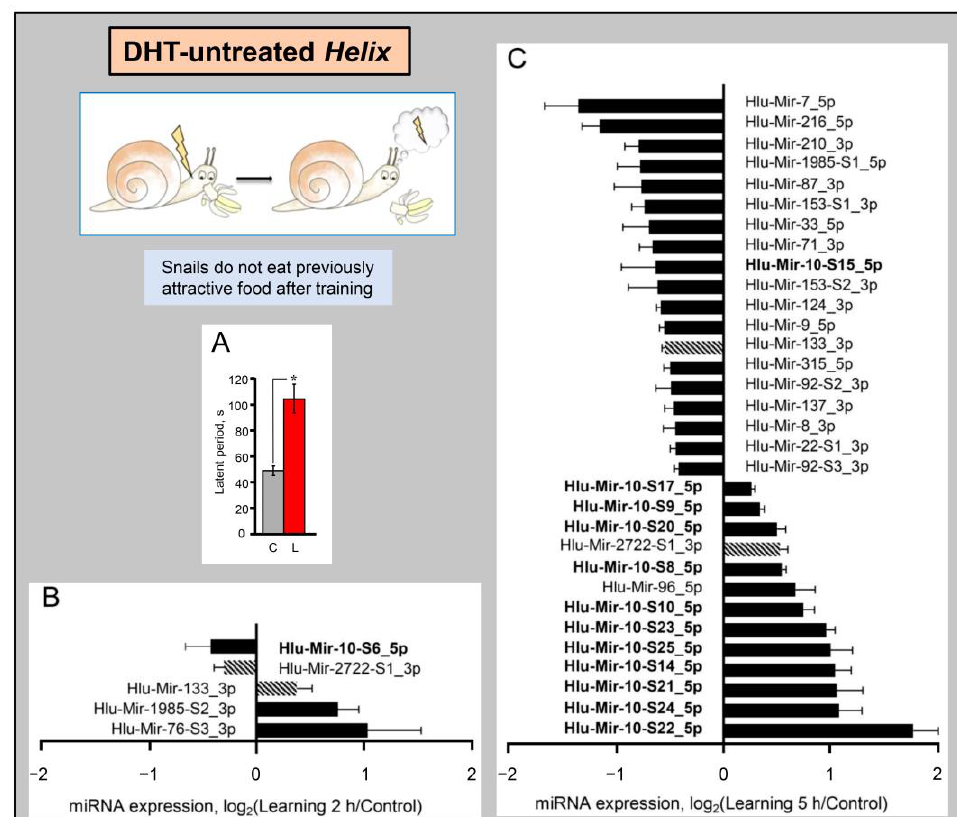
Figure 4. Learning regulates miRNAs expression in Helix CNS. ( A ) The formation of the food-avoidance conditioning in Helix. Testing after 3 days shows significant learning effects. The ordinate is the latent period of the consummatory responses of animals. Designations: C-animals before training ( n = 12), L-trained animals ( n = 12). * p < 0.05. ( B , C )-Relative expression levels of miRNAs 2 h ( B ) and 5 h ( C ) after learning were assessed using next-generation sequencing normalizing first to the total number of miRNA reads in each sample and then to the mean expression value in control groups of naive animals. The hatched columns indicate miRNAs which show differential expression both 2 and 5 h after learning. Statistical significance was assessed using the U-test ( p < 0.05). The error bars represent the standard error of the mean. The number of samples in experimental groups is as follows: Control, n = 10; 2 h post-training, n = 6; 5 h post-training, n = 3.